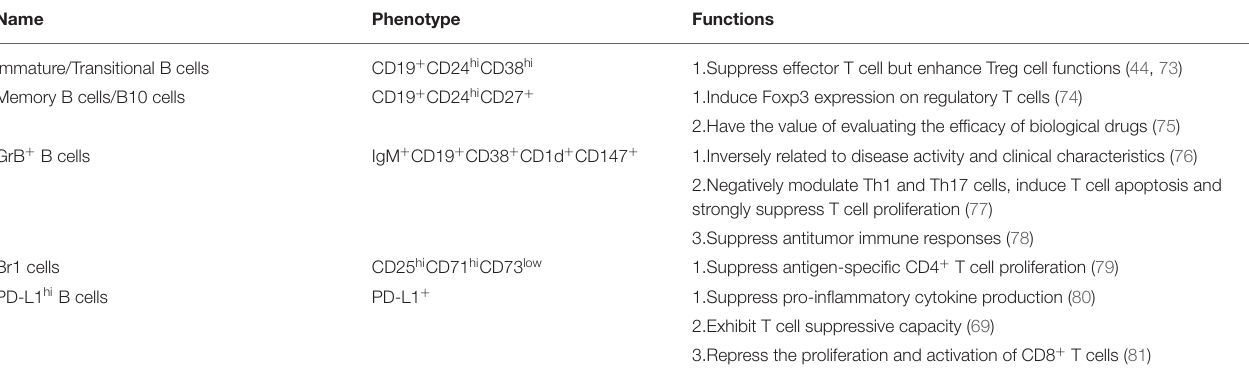
TABLE 2 | The phenotype and function of human regulatory B cell